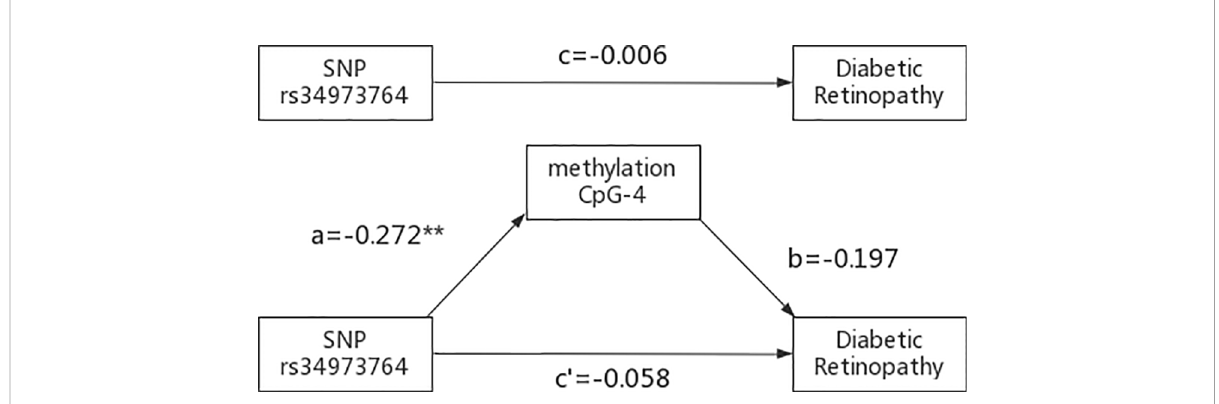
FIGURE 5 Results of the mediation analysis: Indirect effect of rs34973764 on diabetic retinopathy through methylation of CpG-4 and total effect (regression coef fi cients). **p ≤